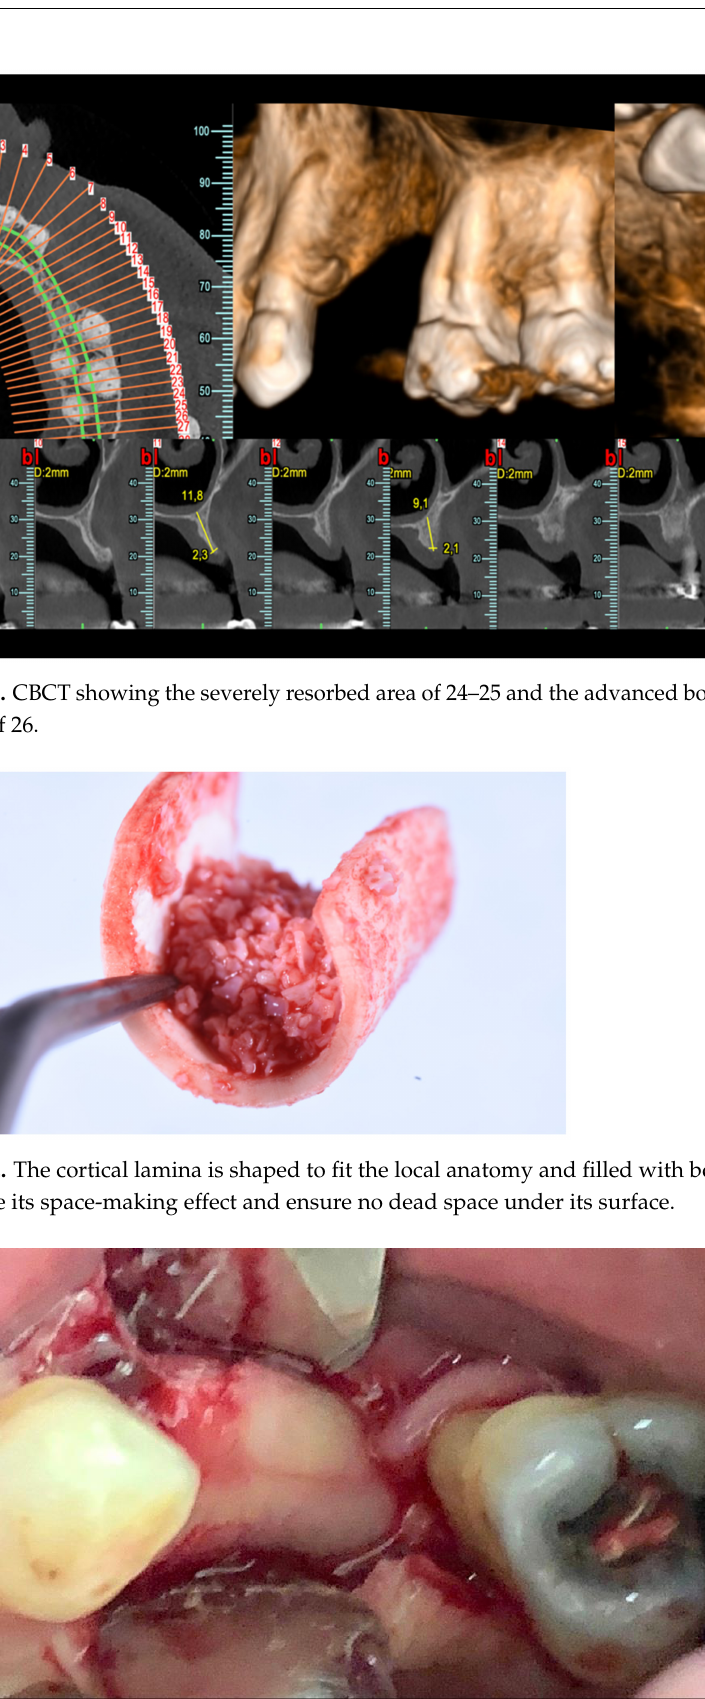
Figure 3. The edentulous ridge is restored to a size allowing the placement of a standard diameter implant, the bone support to the mesial of tooth 26 is also much improved. implant, the bone support to the mesial of tooth 26 is also much